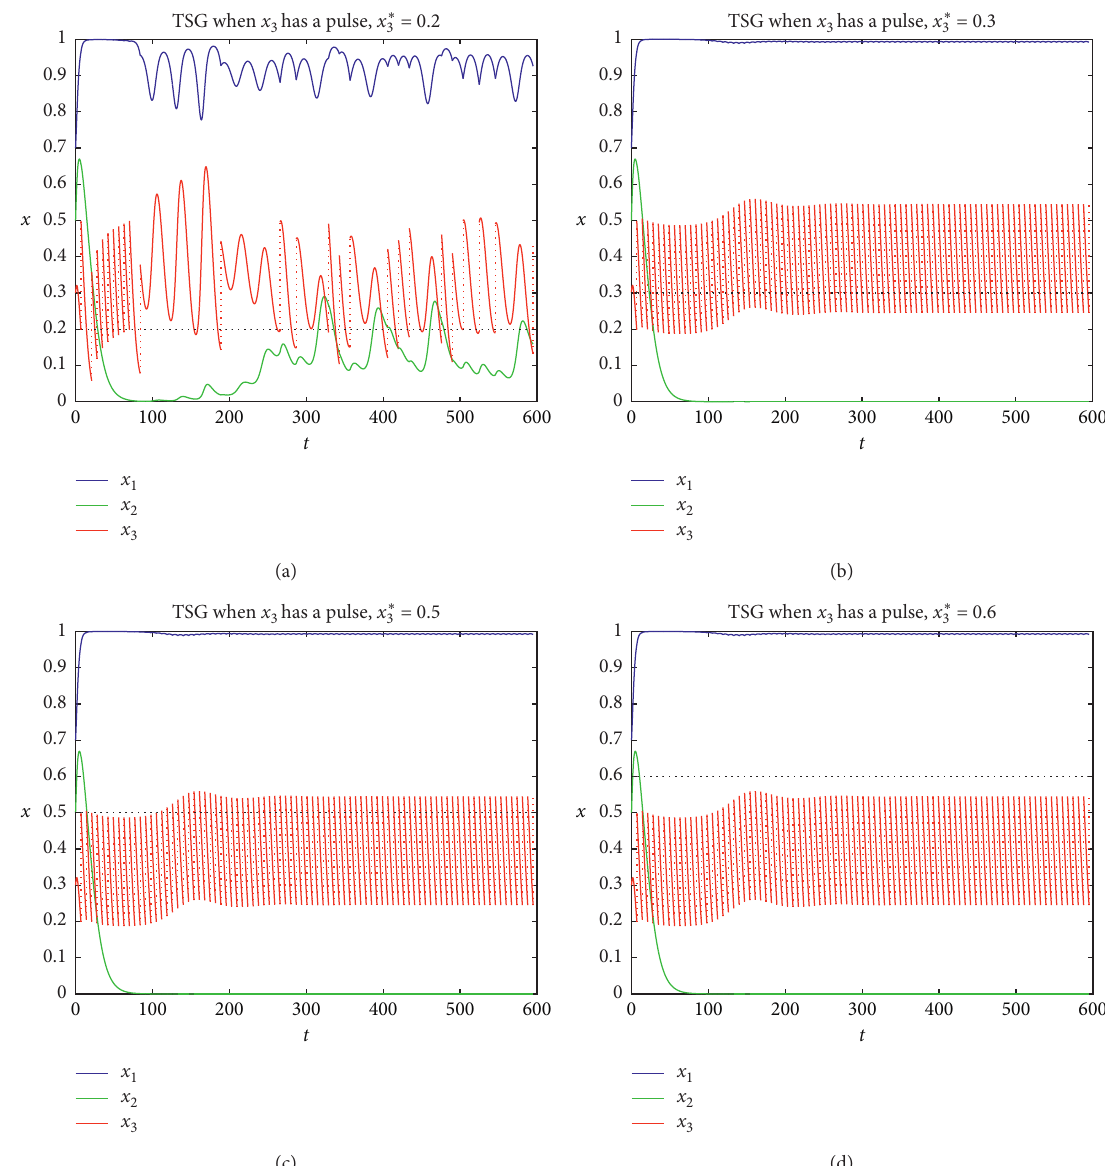
Figure 6: TSGs of DIDEs (4) with TC on x x ∗ � 0 . 5, and (d) x ∗ 3